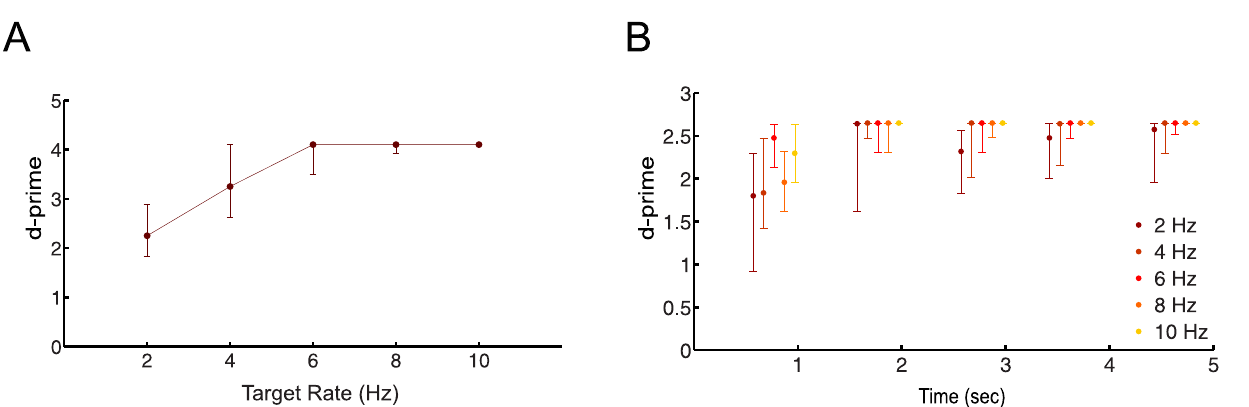
Fig. 2. Behavioral performance improvement with target sequence rate reflected in neural build-up curve. (A) Behavioral performance (Psychoacoustic experiment B, N 5 12) as a function of target sequence rate for an expanded range from 2 to 10 Hz, in steps of 2 Hz. Overall performance increased with presentation rate, eventually reaching the ceiling value of d’ 5 4.1 (for 200 trials) (B) Build-up of the behavioral performance as a function of presentation rate. The time for achieving ceiling detection performance is reduced for faster presentation rates. Results are depicted as median and [25,75]%